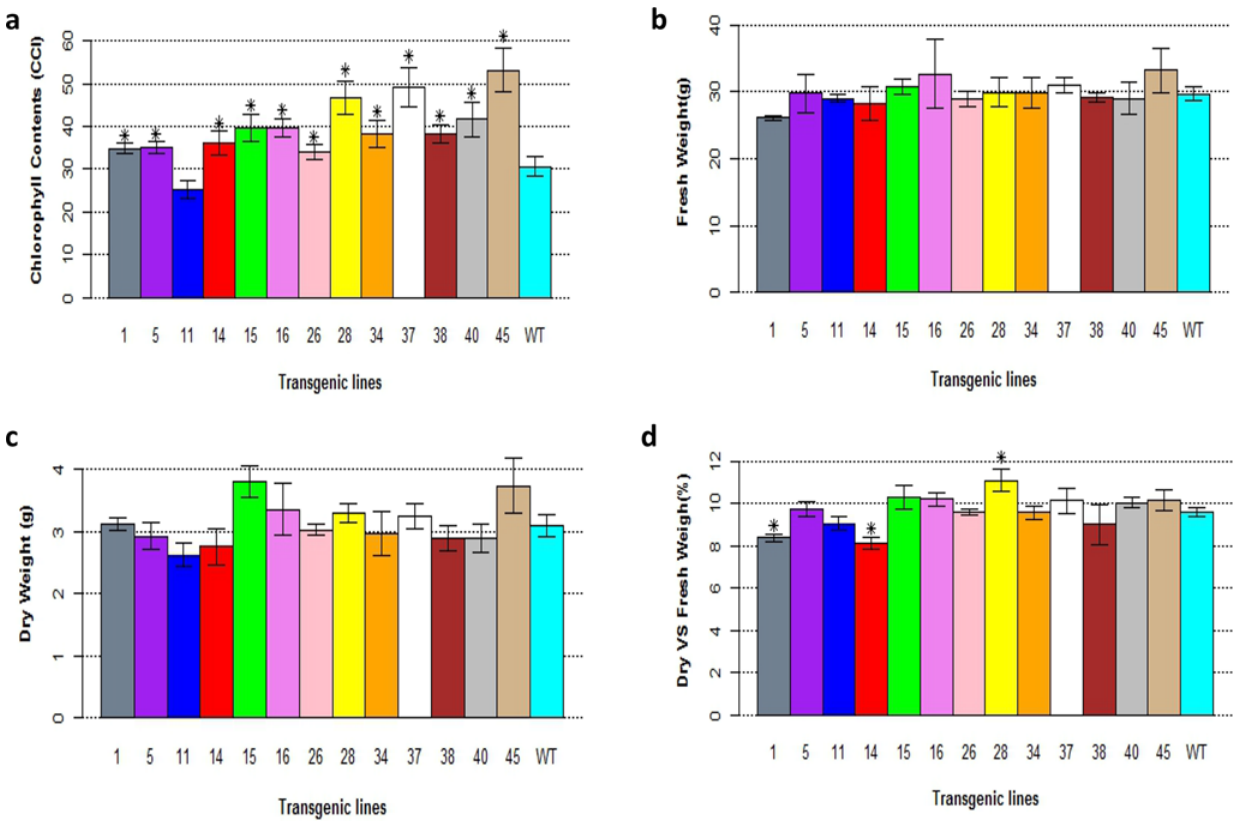
Fig 5. Changes in chlorophyll contents and biomass of PsnSusy2 tobacco transgenics. a. Chlorophyll contents of the third, fourth and fifth functional leaves of different PsnSuSy2 tobacco transgenic lines of two-month-old plants. b. Fresh weights of three-month-old PsnSuSy2 tobacco transgenic lines. c. Dry weights of three-month-old PsnSuSy2 tobacco transgenic lines. d. Ratios of dry vs. fresh weight for of three-month-old PsnSuSy2 tobacco transgenic lines. All measurements shown in 5a, 5b, and 5c were averaged from five different samples per line ± S.E. The t -test was used to examine the significance of difference between PsnSusy2 transgenic and wildtype lines, and * denotes significance at p < 0.05. The WT represents wildtype tobacco while the others lines labeled with line numbers are of different PsnSusy2 tobacco transgenic lines.